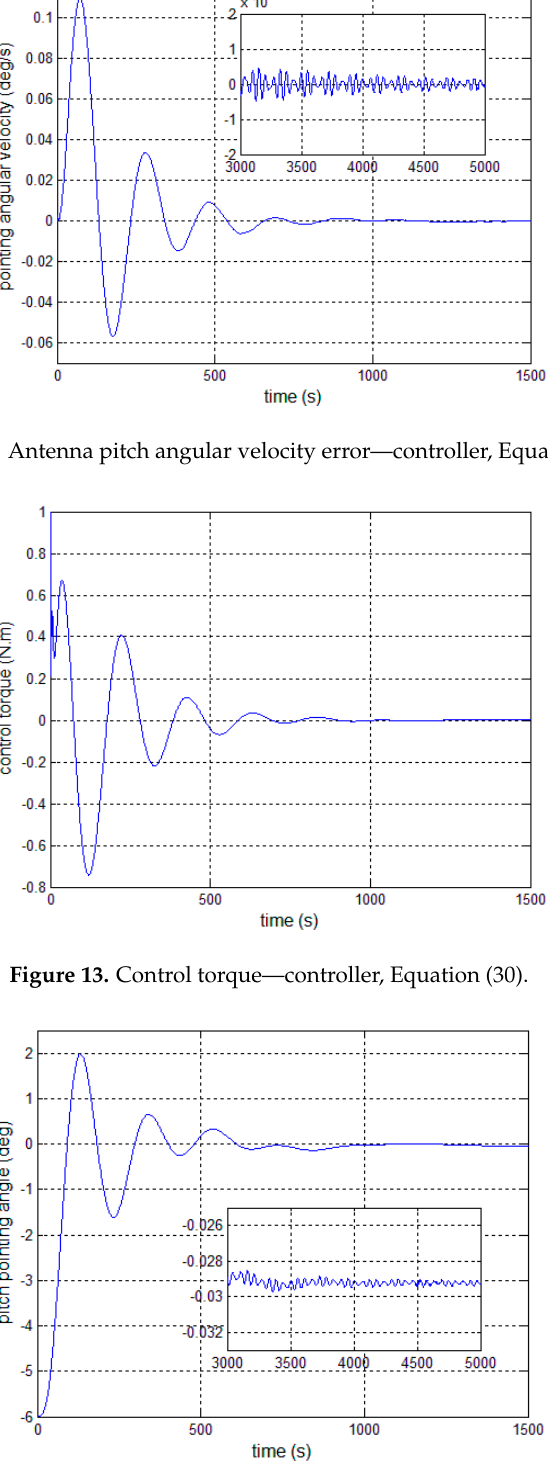
Figure 15. Antenna pitch angle error—controller, Equation (31).